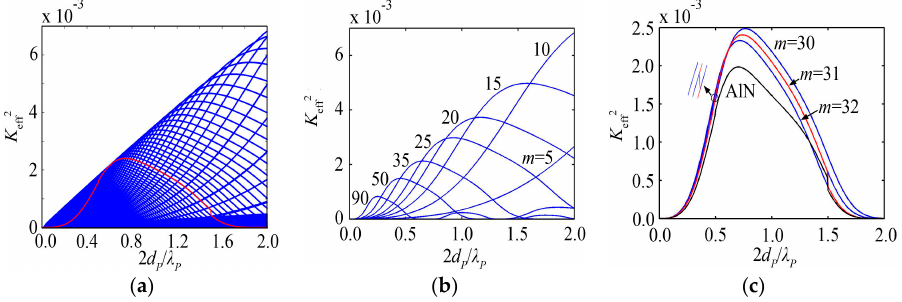
Figure 6. The HBAR consisting of ZnO/Sapphire 55.78 μ m ; ( a ) The variation curve of K eff2 with the piezoelectric film thickness; ( b ) The partial modes of HBAR shown in Figure 6a; ( c ) The partial enlarged drawing of Figure 6a close to mode m = 30.